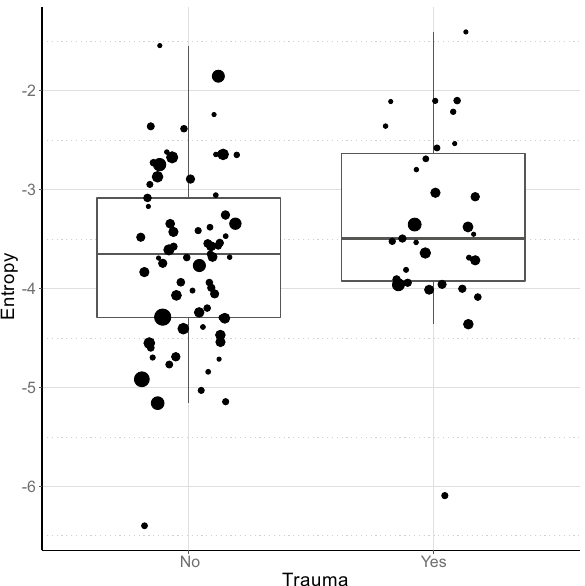
Figure 9. The effect of trauma experienced on the entropy of whines produced during separation. Traumatized dogs had whines with slightly higher entropy. The horizontal line within the box shows the median, the boxes represent the interquartile intervals, the whiskers the range. The size of the dots is proportional with the number of whines